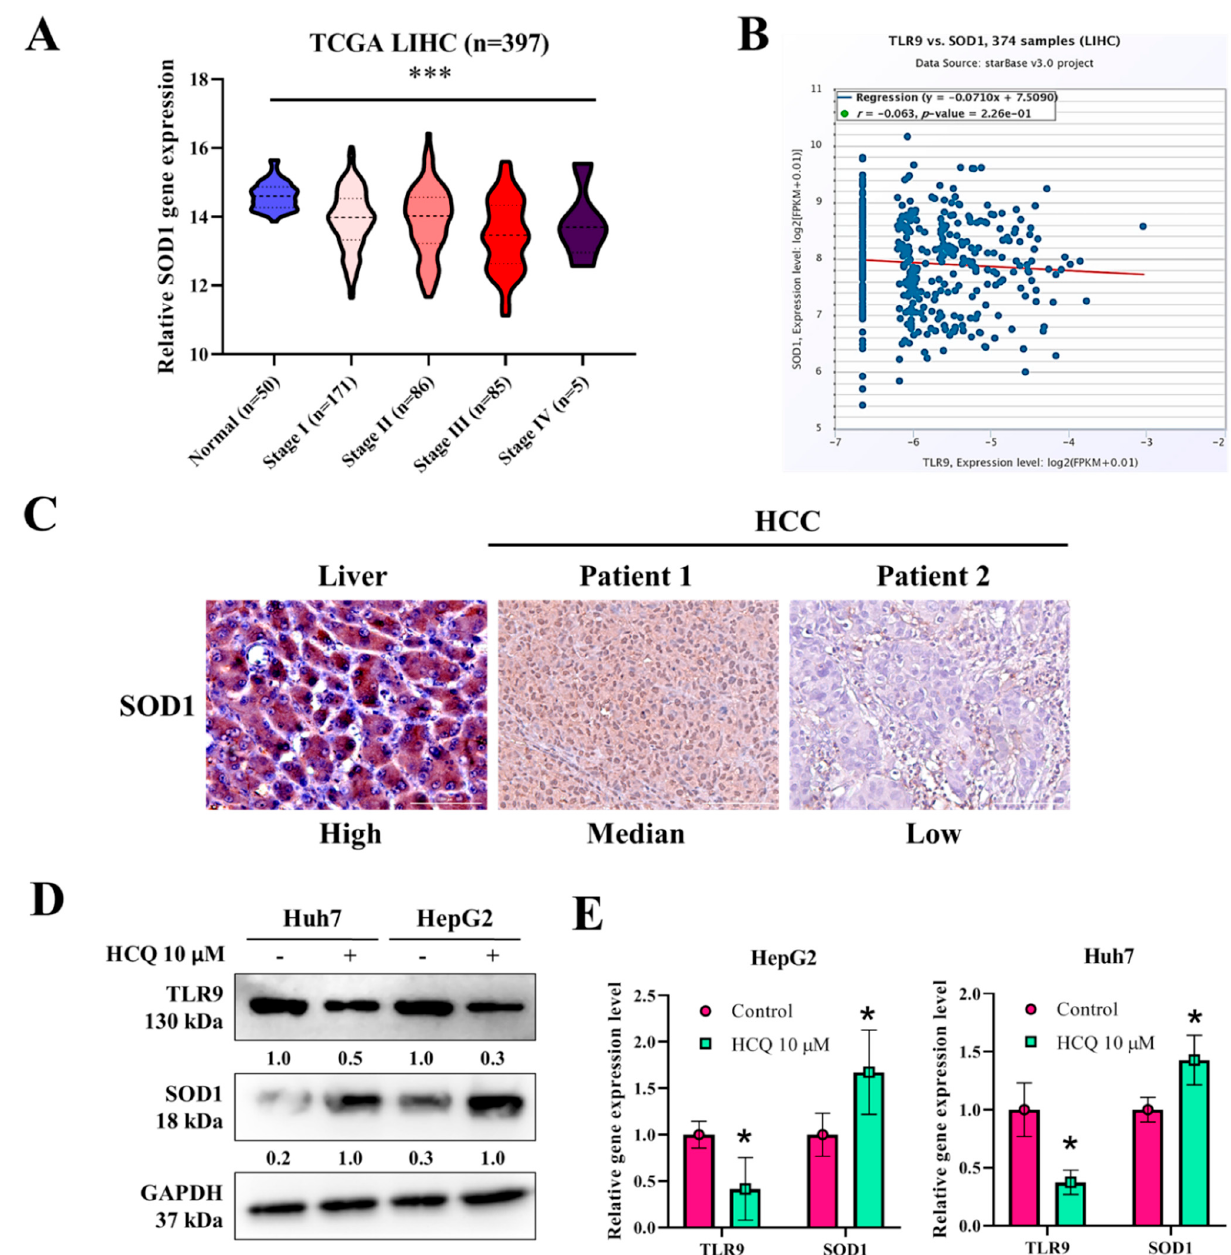
Figure 5. HCQ treatment modulated the expression of antioxidant enzyme expression in HCC cells. ( A ) SOD1 expression in TCGA-LIHC patients at higher grade compared to normal samples, analyzed using online UALCAN tool; http://ualcan. path.uab.edu/cgi-bin/ualcan-res.pl (accessed on 15 June 2020). ( B ) Correlation analysis of TLR9 expression with SOD1 expression in TCGA-LIHC samples analyzed using online starBase v3.project tool; http://starbase.sysu.edu.cn/ (accessed on 15 June 2020). ( C ) Immunohistochemistry indicated a reduced expression of TLR9 in the HCC tumor tissues. ( D ) Western blot and qRT-PCR analysis expression of TLR9 and SOD1, or GAPDH (loading control). Representative protein bands are shown a reduction in expression of TLR9 and SOD1 observed after the HCQ treatment (10 µ M). ( E ) mRNA expression of TLR9 and SOD1 was measured by qRT-PCR; GAPDH was used to normalize the expression levels. Data are the mean ± SEM of three independent experiments. * p < 0.05, *** p <